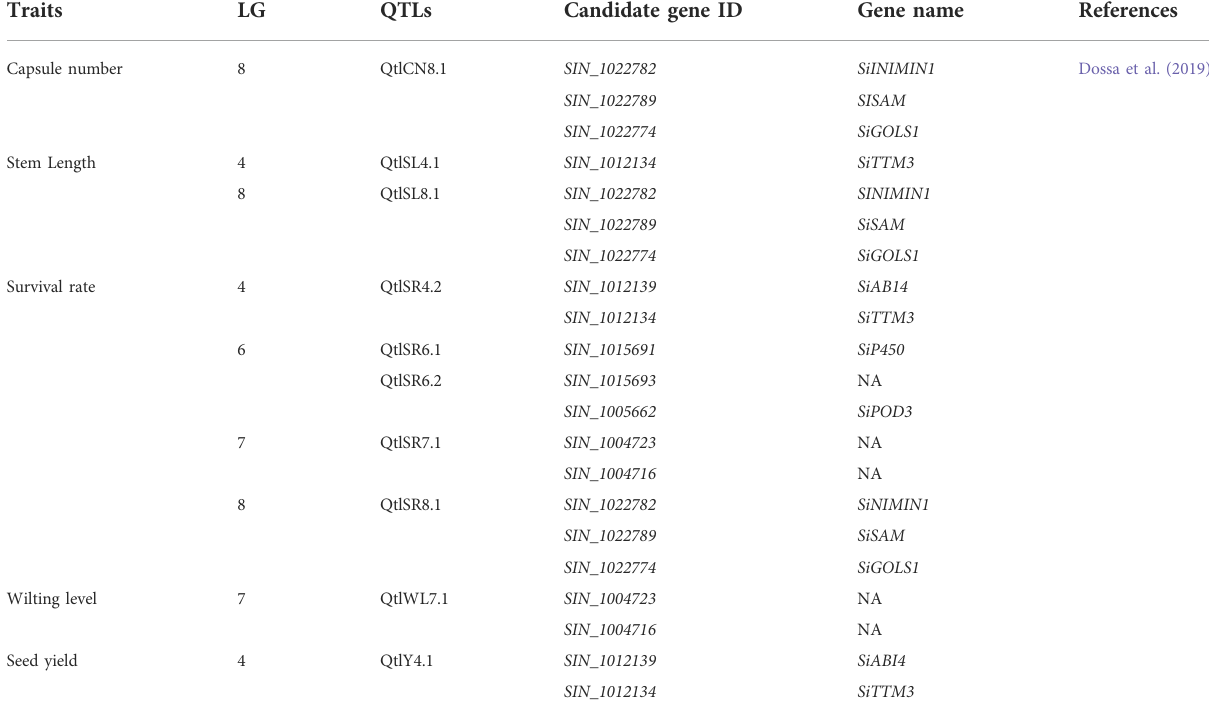
TABLE 11 Identi fi ed drought-tolerant QTLs, genes, and SNPs in sesame. Traits LG